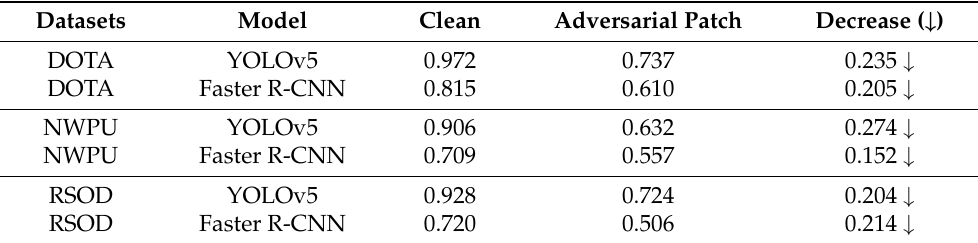
Table 4. Scenario B: Attack transferability of